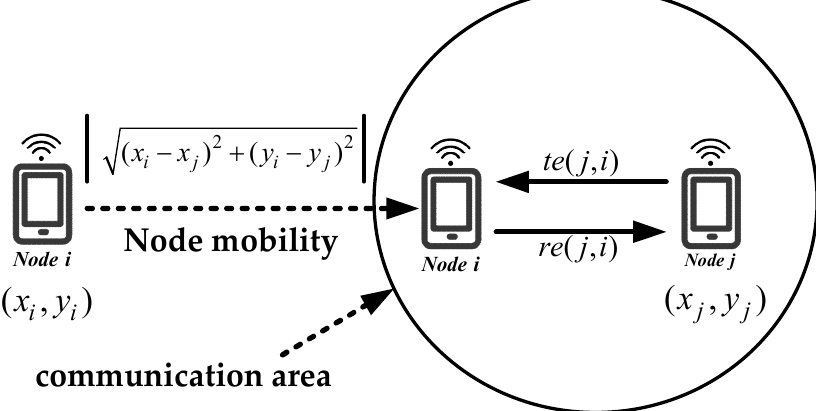
Figure 2. Energy consumption model for data transmission in opportunistic social networks.